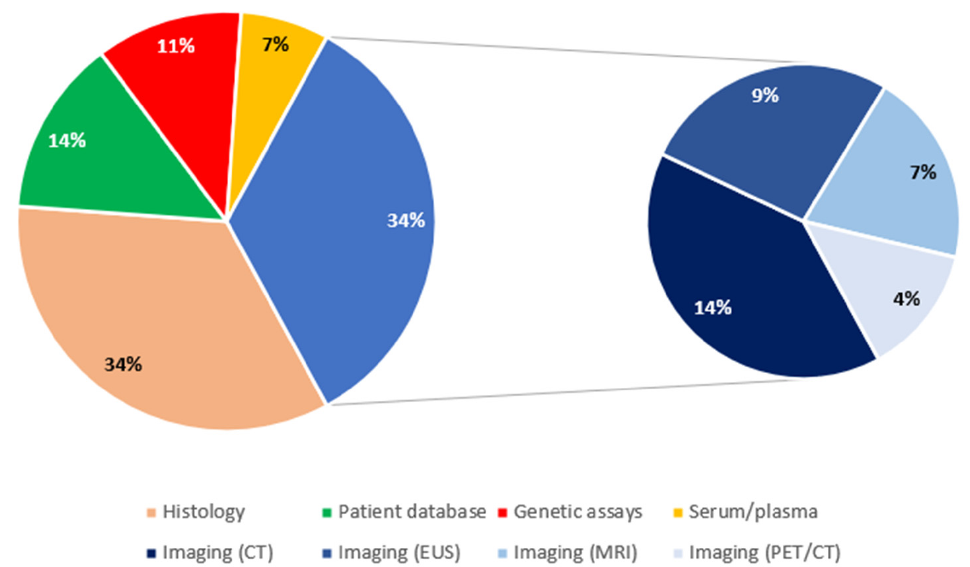
Figure 5. Distribution of studies by source of data. CT: computed tomography; EUS: endoscopic ultrasound; MRI: magnetic resonance imaging; PET: positron emission tomography.